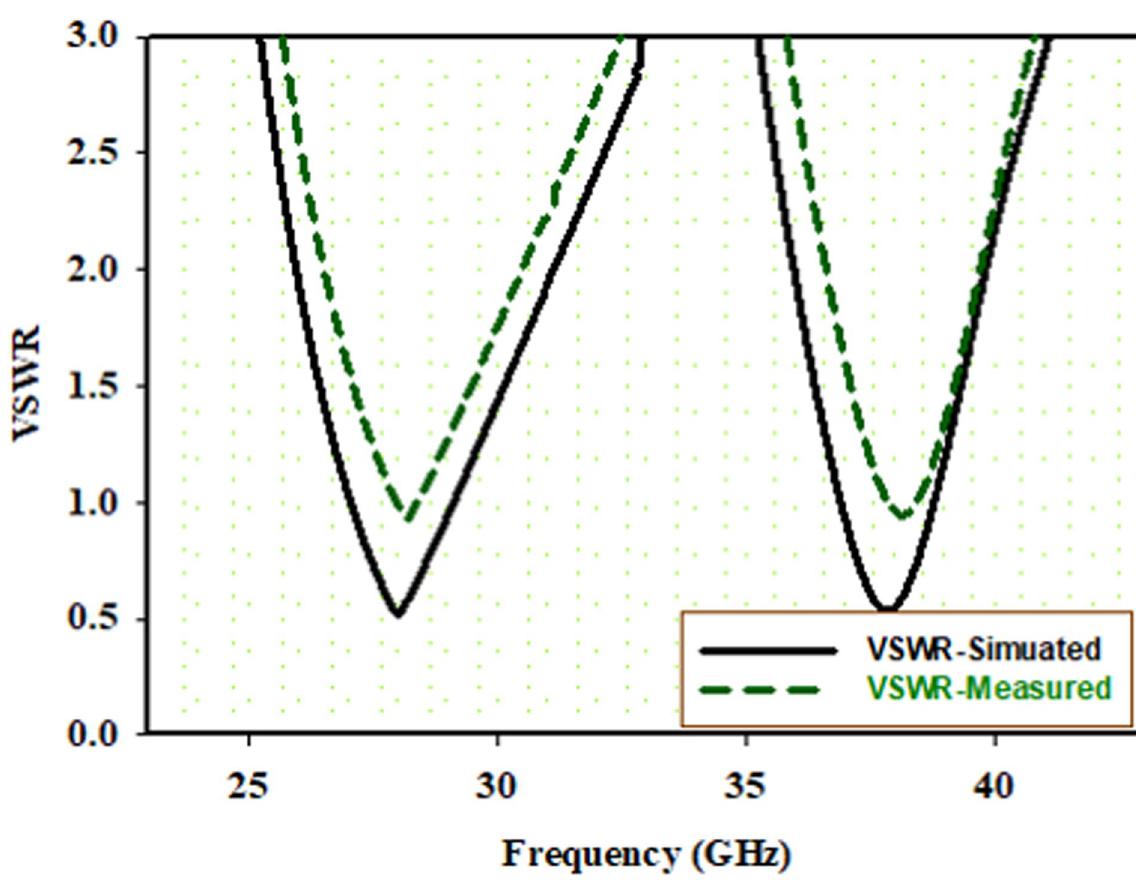
Fig 5. VSWR result when both S1 and S2 are at ON